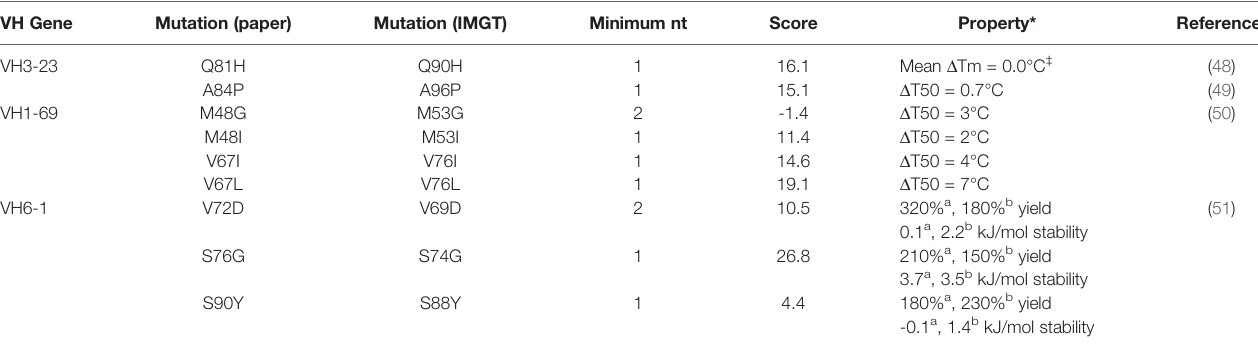
TABLE 2 | Differential stabilities for individual framework point